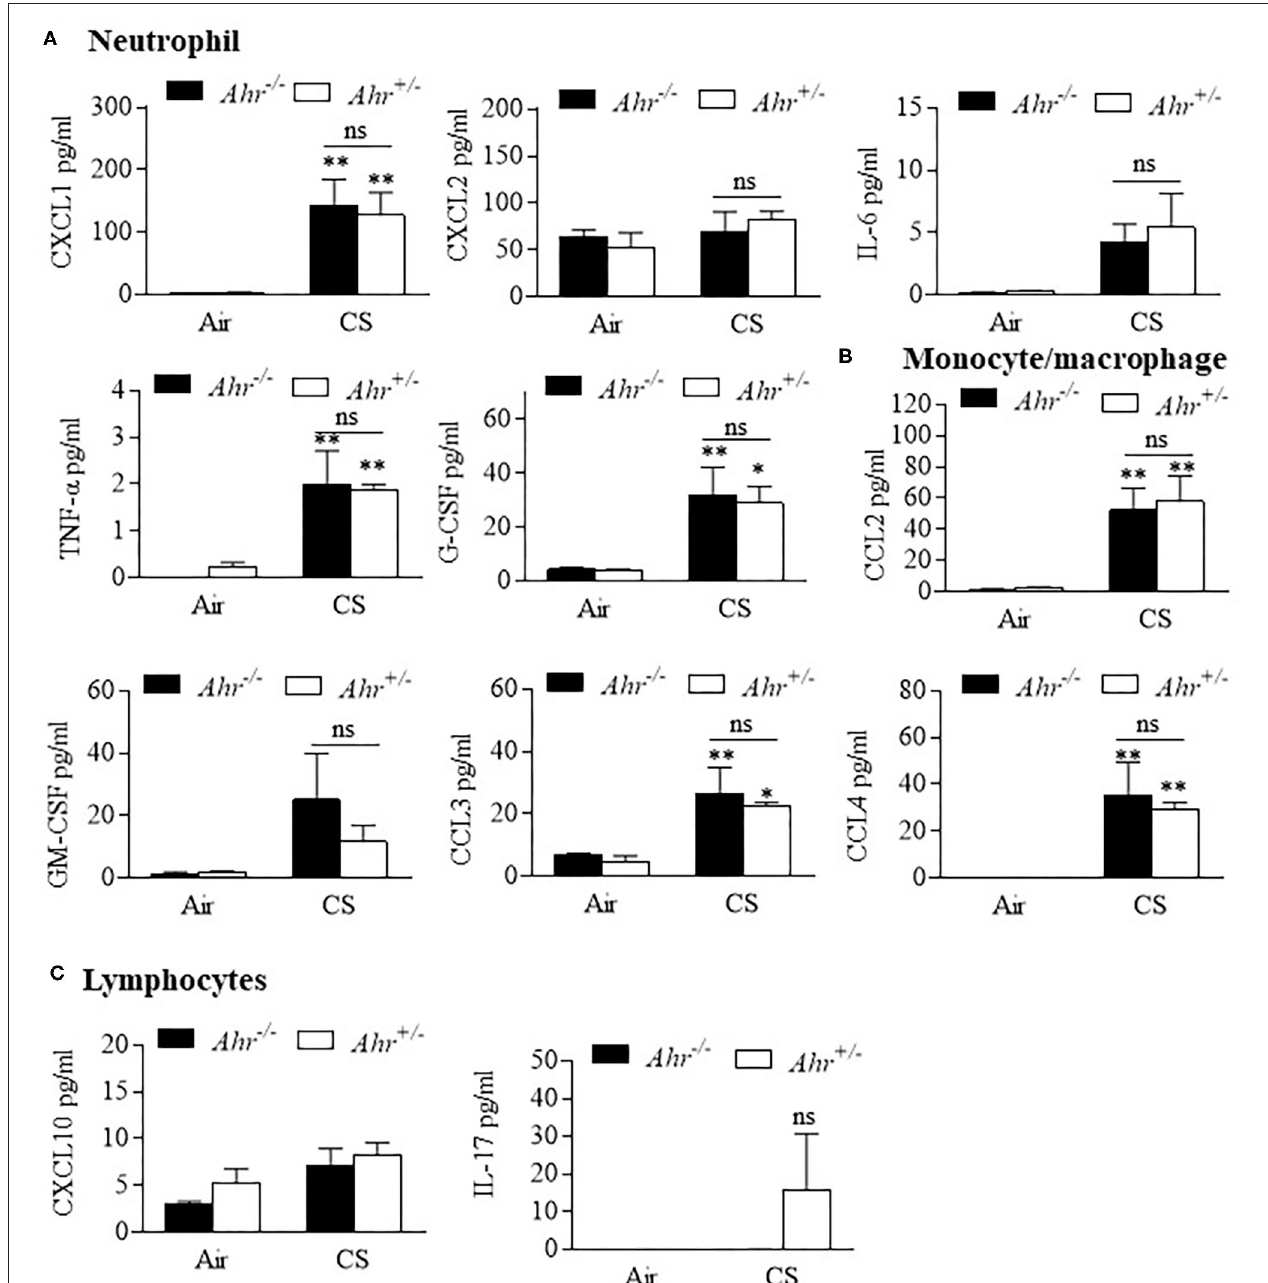
FIGURE 4 | BAL cytokines are similar between chronic 4-month cigarette smoke-exposed Ahr + / − and Ahr − / − mice. Ahr + / − and Ahr − / − mice were exposed to a 4-month CS regime and cytokines analyzed in the BAL fluid by multiplex analysis. (A) Neutrophils- there was an overall increase in the levels of CXCL1, IL-6, TNF- α and G-CSF after 4 months of CS exposure (* p < 0.05, ** p < 0.01 compared to corresponding air-control); there was no significant difference (ns) between smoke-exposed Ahr + / − and Ahr − / − mice. (B) Monocyte/macrophage- although CS generally increased BAL levels of CCL2, CCL3, and CCL4, there was no significant difference between Ahr + / − and Ahr − / − mice. (C) Lymphocytes- there was no significant change in CXCL10 or IL-17 in response to CS. Results are shown as means ± SEM ( n = 4–5 mice per group); 2-way ANOVA followed by the Neuman-Keuls multiple comparisons test.